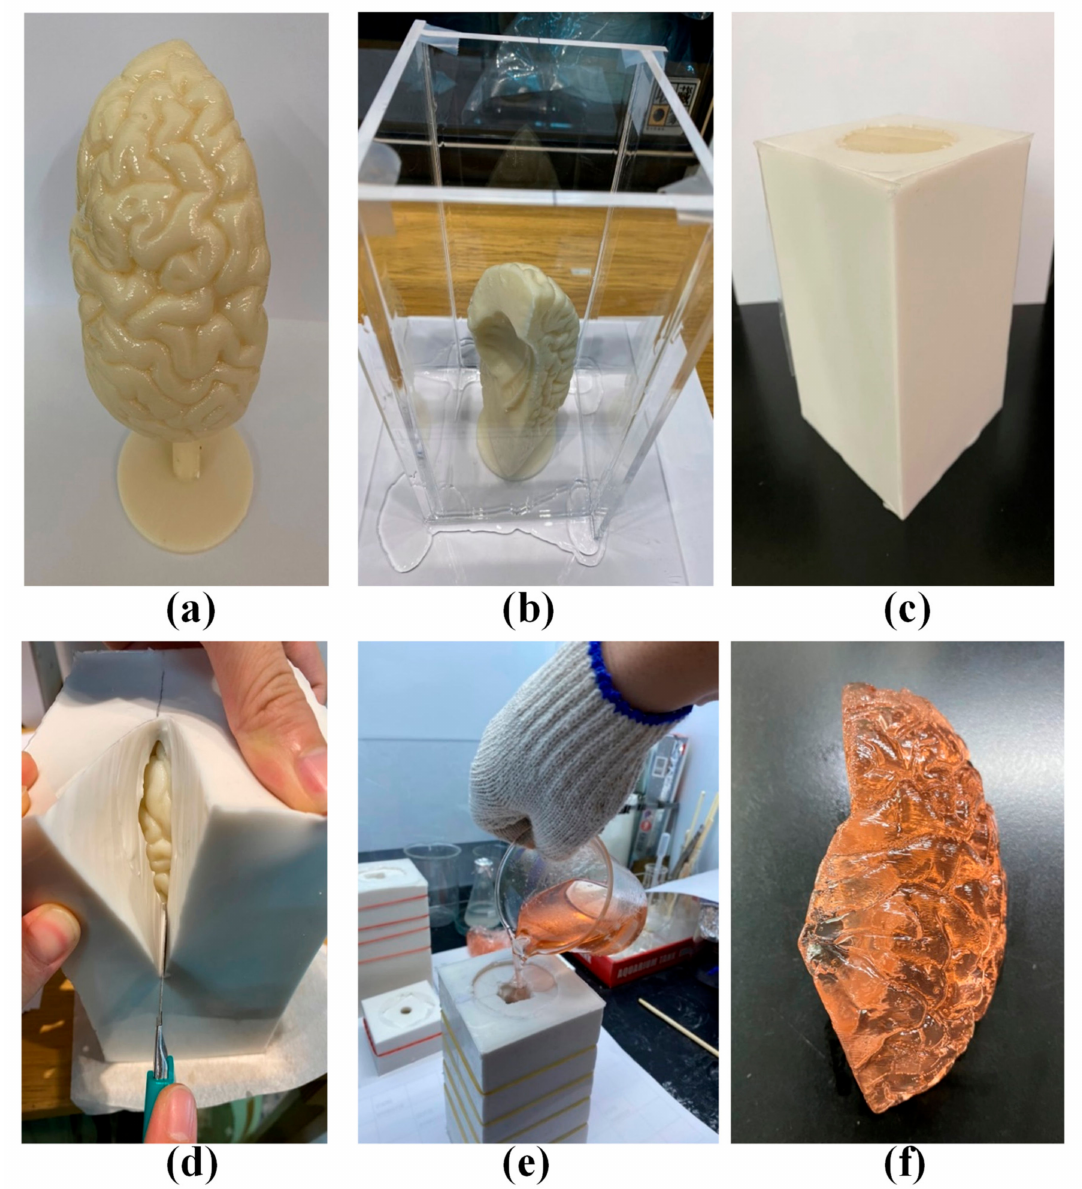
Figure 4. ( a ) A mold of the left frontal lobe printed using a 3D printer (Fortus 360mc, Stratasys); ( b , c ) the acrylonitrile butadiene styrene (ABS) mold was fixed within a transparent box into which silicon was poured to create a cast; ( d ) the ABS mold was sliced open using a knife and then peeled back to remove the ABS mold; ( e ) a mixture of pink jelly was poured into the cavity; ( f ) a realistic model of the frontal lobe was